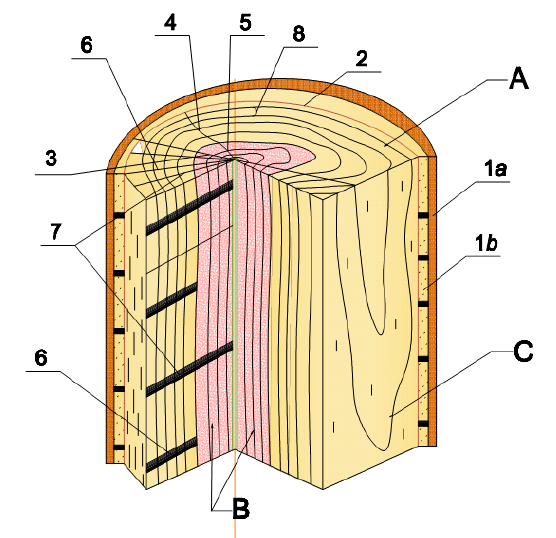
Figure 1. Macroscopic sections of Osier willow (adaptation from [8]): A—cross section; B—longitudinal–radial section; C—longitudinal–tangential section; 1a—ritidom, 1b—liberum, 2—cambium tissue, 3—pith, 4—sapwood, 5—heart wood, 6—simple radius, 7—medulary radius, 8—annual ring.